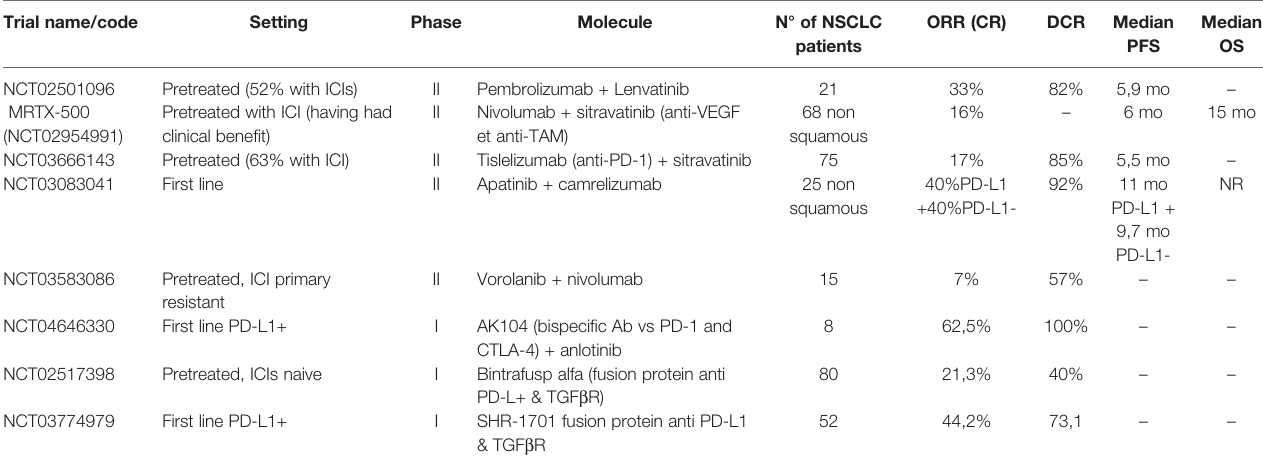
TABLE 3 | Results of clinical trial for new agents targeting Tumor Microenvironment